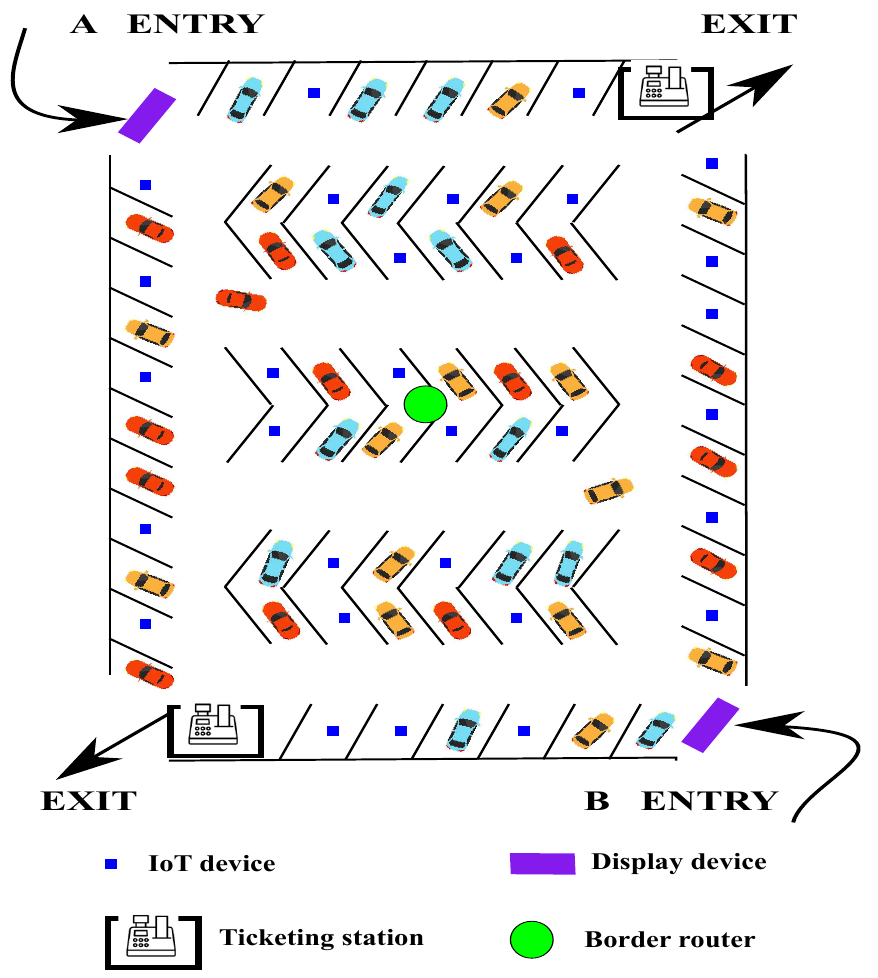
Figure 1. IoT infrastructure in a standalone parking